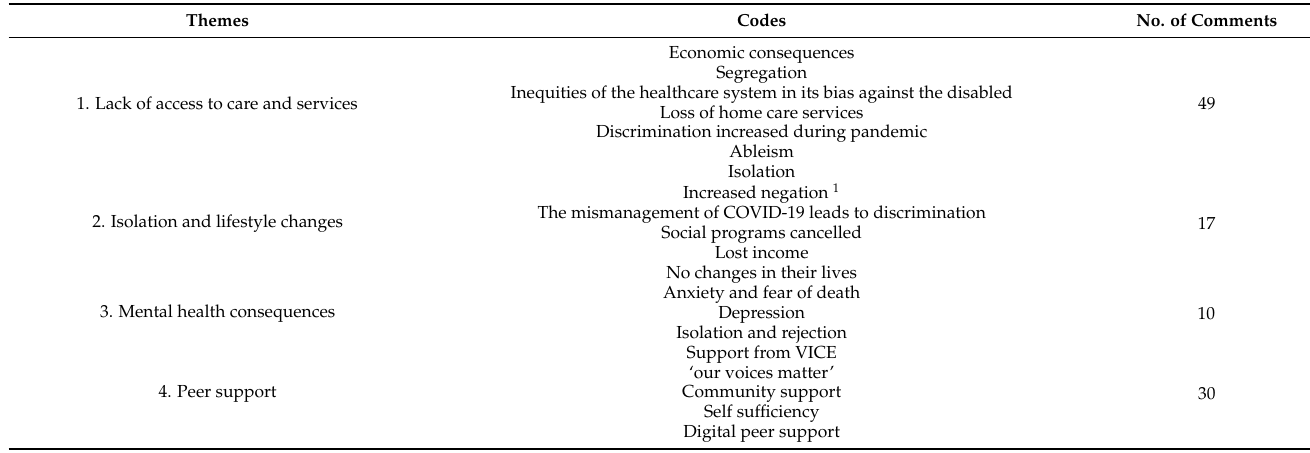
Table 1. Themes and